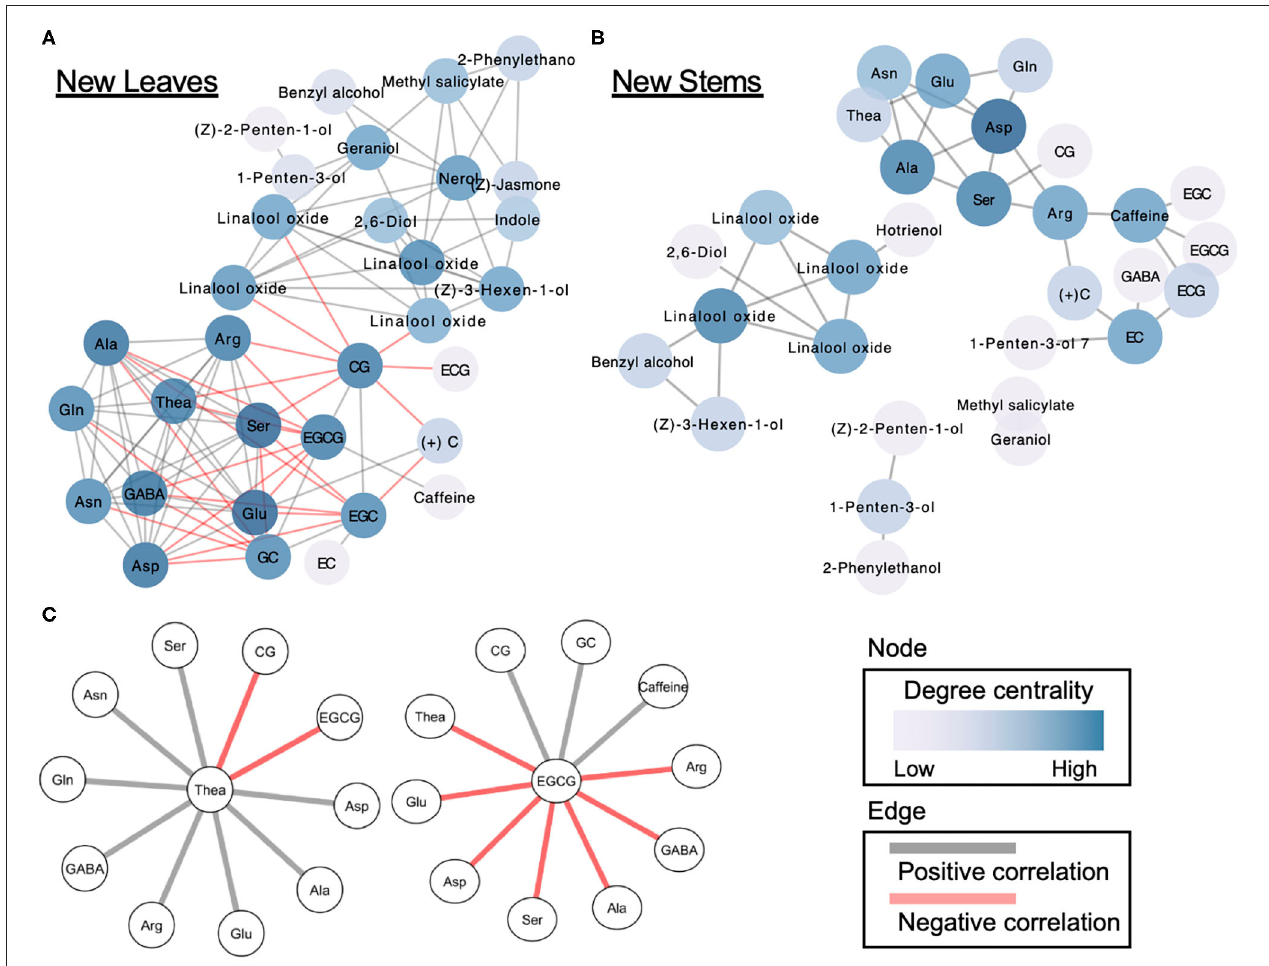
FIGURE 5 | Correlation network-based analysis of tea quality-related metabolites in new leaves (A) and stems (B) . Node colors indicate degree centrality levels, respectively. Gray and red edge colors indicate positive and negative correlations, respectively. Metabolites forming networks directly with theanine and EGCG (C) in new